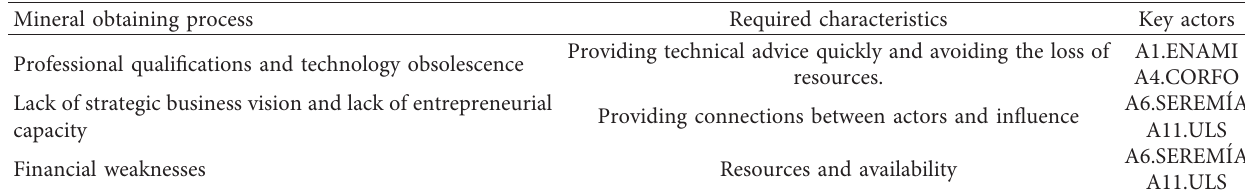
Table 10: Mineral obtaining process problems vs. key